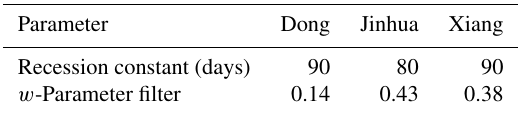
Table 4. Parameters of